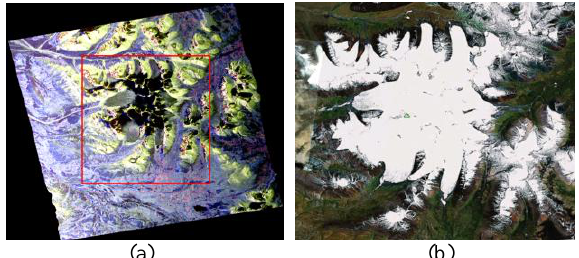
Figure 1 satellite images of the Donglemadi Basin. (a)Pauli- baesed colored PolSAR image; (b) the optical image (from Google Earth)